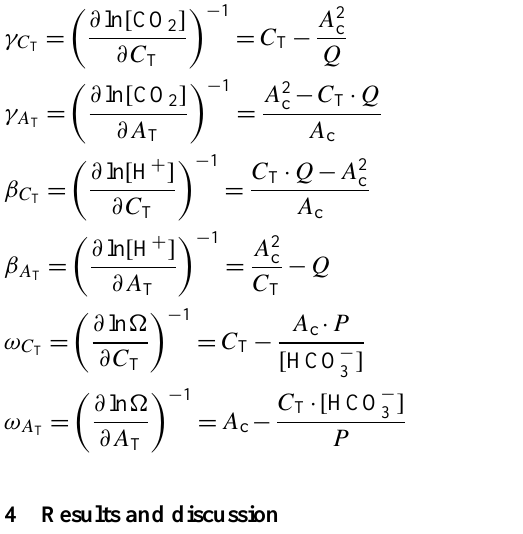
36 ◦ S to 8.040 all along 36.5 ◦ S to 37.8 ◦ S. Between A2 and A3, the pH T , 25 shifted from 8.040 to 7.946, increasing